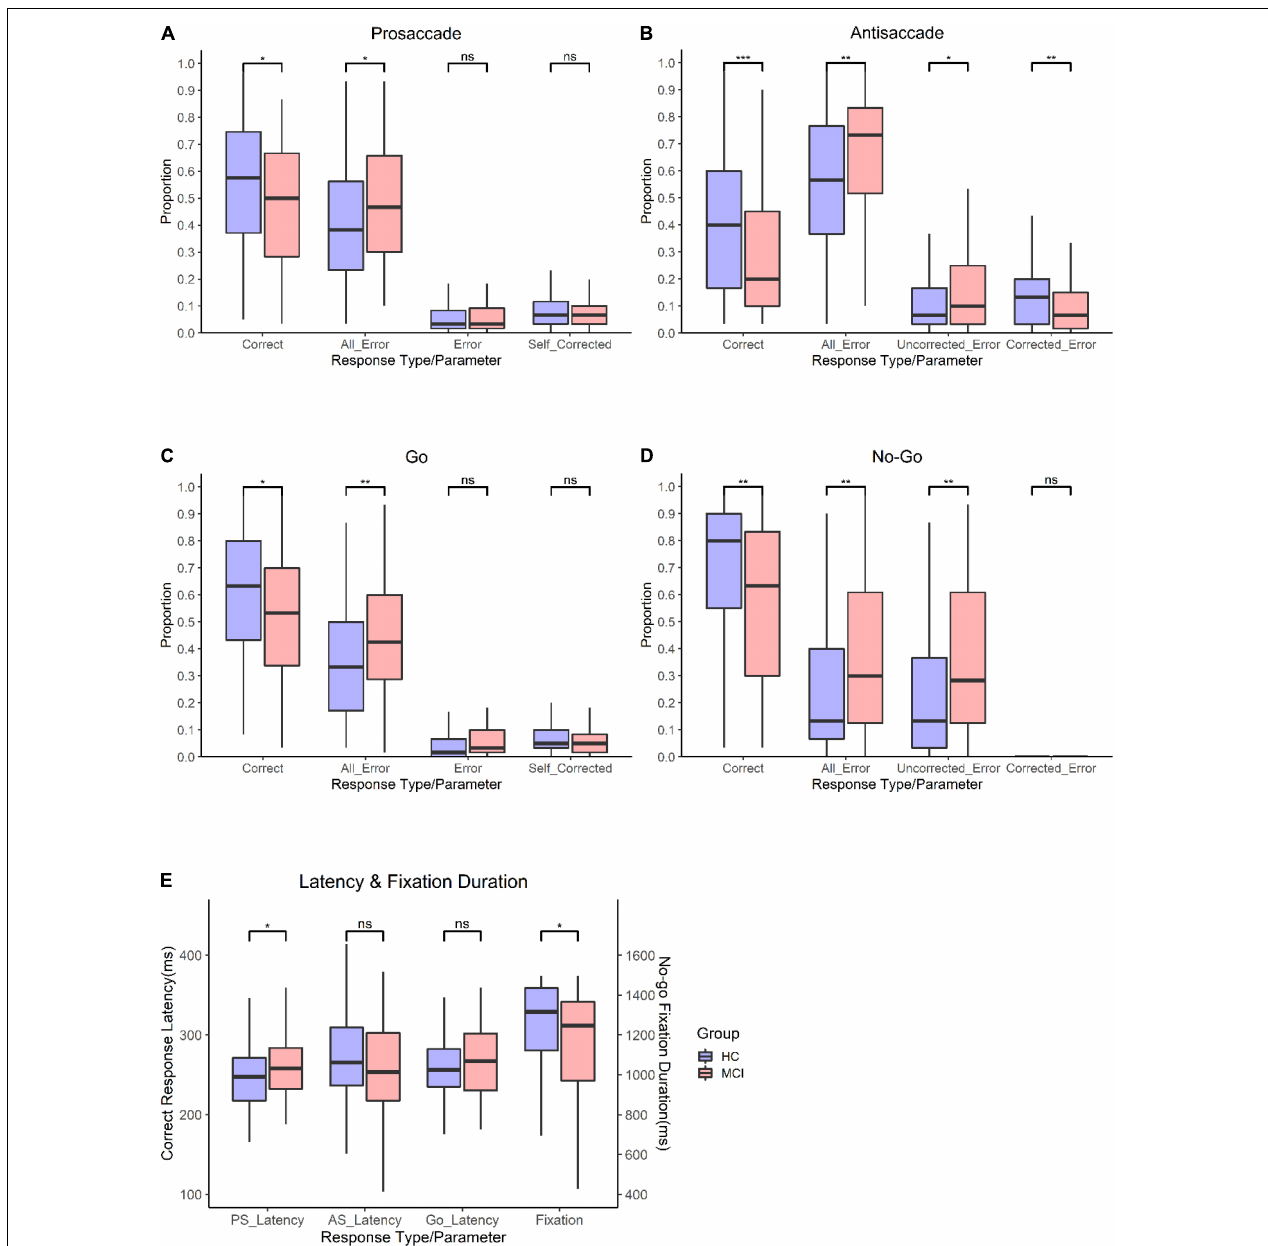
FIGURE 3 | Oculomotor responses in controls and patients with MCI. (A) Proportion for prosaccade trials. (B) Proportion for antisaccade trials. (C) proportion for go trials. (D) Proportion for no-go trials. (E) Latency for PS, AS, Go trials, and proportion and fixation duration for no-go trials. **Significance level p < 0.001; *significance level p < 0.05; n.s., not